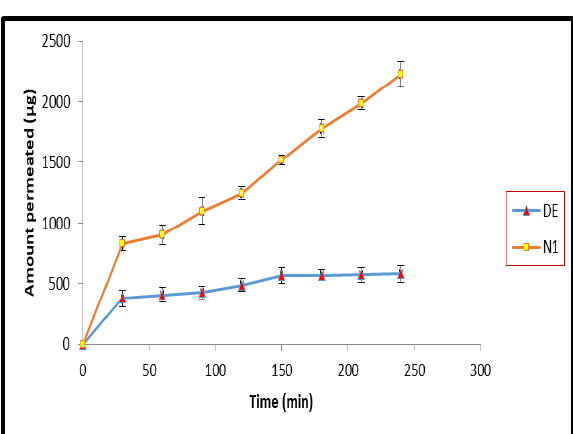
Figure 4. Permeation of dabigatran etexilate from optimized formula N1 and pure drug suspension through non-everted rat duodenum, values of mean ±SD (n=3).